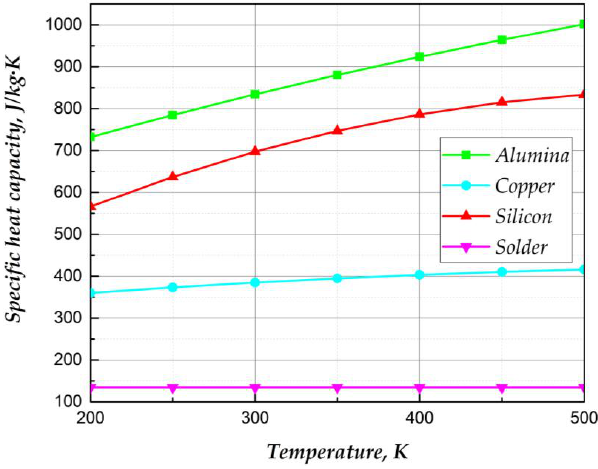
Figure 3. The relationship between specific heat capacity and temperature of different materials.